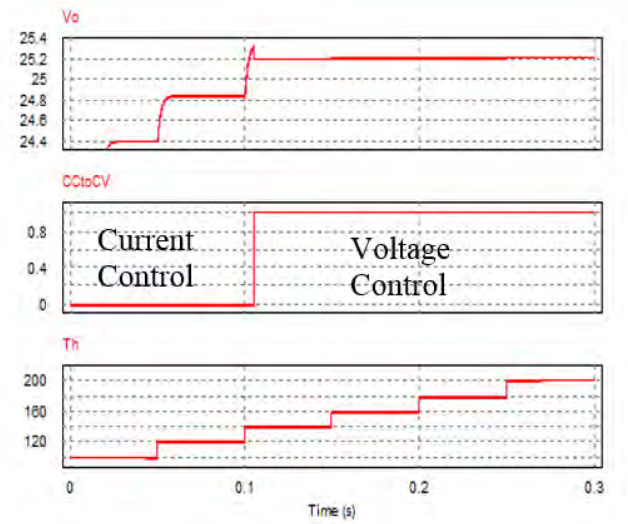
Figure 14. Output voltage at different hot side temperatures in the full operation range of 100 ◦ C to 200 ◦ C during voltage control stage